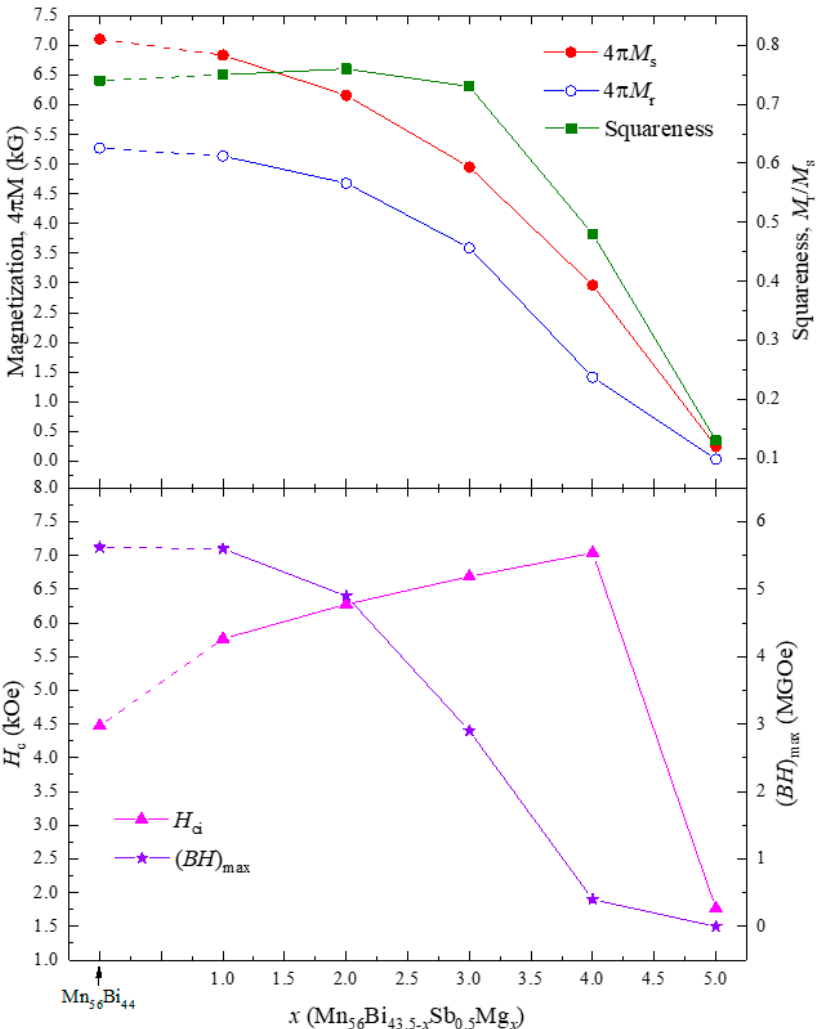
Figure 8. Composition dependence of magnetization, squareness, H c , and ( BH ) max for Mn 56 Bi 43.5 − x Sb 0.5 Mg x (0 ≤ x ≤ 5) bulk samples.